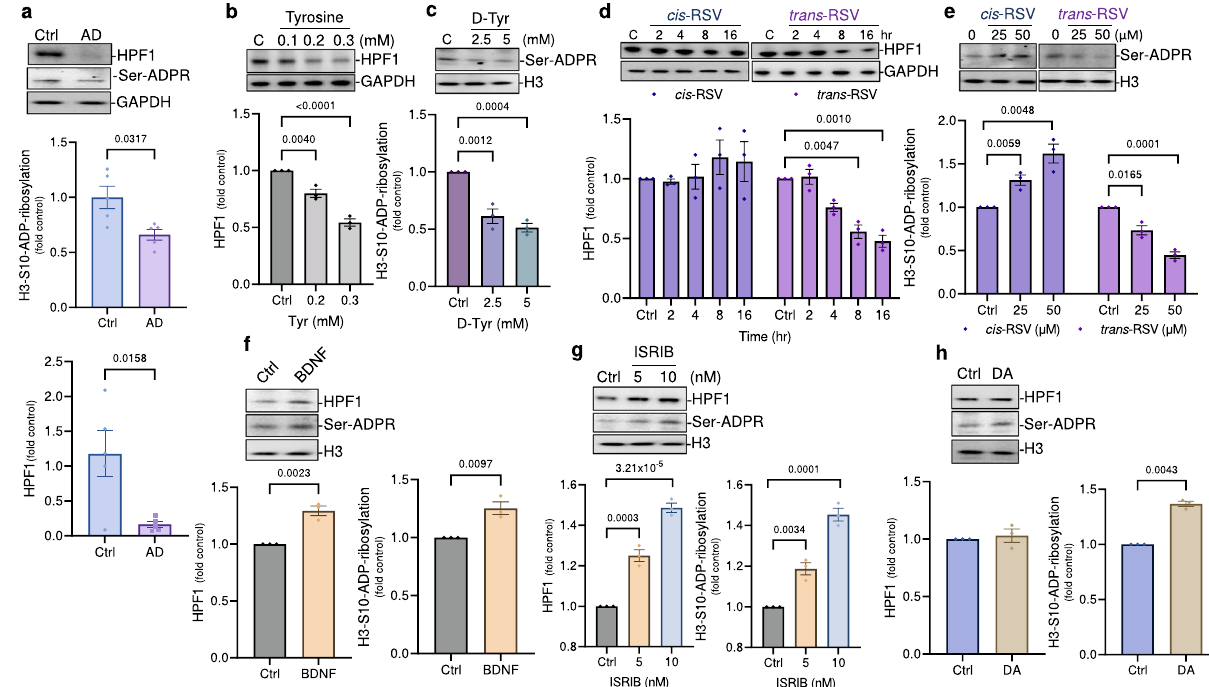
Fig. 6 Histone serine-ADP-ribosylation is decreased in AD brains and cis - and trans -RSV have opposite effects on it. a HPF1 and histone serine-ADP- ribosylation are decreased in the hippocampal region of AD patients . Representative immunoblots and quanti fi cation for HPF1 and histone H3-Ser10-ADP- ribosylation (Serine-ADPR) using anti-HPF1 and anti-H3-Ser10-ADPR antibodies, respectively, in the hippocampal region of AD patients ( n = 5) with age and sex-matched controls ( n = 5). b Tyrosine decreases the protein levels of HPF1 . Representative immunoblots and quanti fi cations for HPF1 in rat cortical neurons (DIV 9/10) after treatment with Tyr ( ≤ 300 μ M) for up to 8 h for n = 3 experiments. c D-tyrosine inhibits serine-ADP-ribosylation . Representative immunoblots and quanti fi cation for histone H3-Ser10-ADP-ribosylation levels in cortical neurons (DIV 9) using anti-H3-Ser10-ADPR antibody after treatment with D-tyrosine (2.5 and 5 mM). d , e cis-and trans-RSV have opposite effects on HPF1 and histone serine-ADP-ribosylation levels . Representative immunoblots and quanti fi cation for HPF1 and histone H3-Serine-ADPR using anti-HPF1 and anti-H3-Ser10-ADPR antibodies, respectively in cortical neurons after treatment with cis -and trans -RSV (25 – 50 μ M). f , g BDNF and ISRIB increase HPF1 levels along with the activation of histone serine-ADP- ribosylation . Representative immunoblots and quanti fi cation for HPF1 and histone H3-Serine-ADPR using anti-HPF1 and anti-H3-Serine-ADPR antibodies, respectively in cortical neurons after treatment with BDNF (50 nM) and ISRIB (5 and 10 nM). h DA activates histone serine-ADP-ribosylation . Representative immunoblots and quanti fi cation for histone H3-Ser10-ADPR levels in cortical neurons (DIV 9) using anti-H3-Ser10-ADPR antibody after treatment with DA (250 μ M) for 5 – 10 min. All data represent mean ± SEM for n = 3 experiments with signi fi cance measured using ANOVA with Dunnett ’ s test for multiple